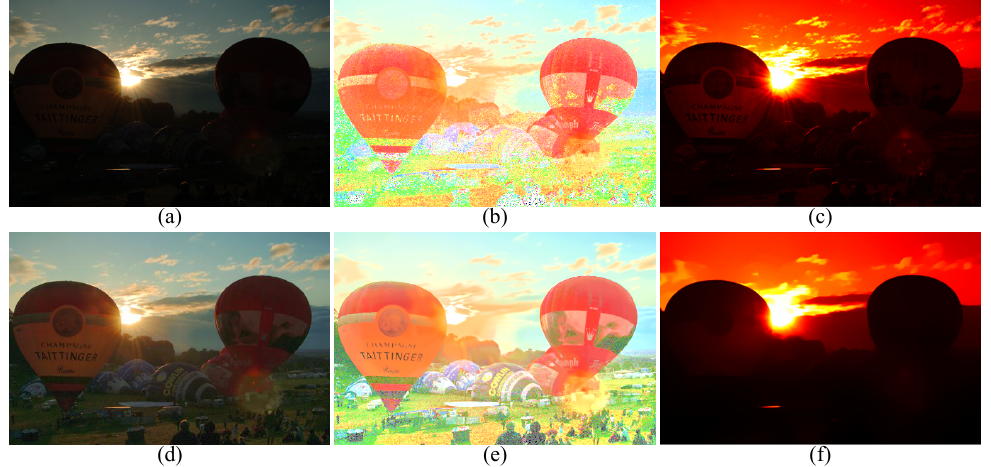
Figure 9. Visual evaluation of Retinex decomposition. ( a ) Original low-light image, ( b ) initial reflectance component ˆ R , ( c ) initial illumination component ˆ L , ( d ) corresponding enhancement result, ( e ) refined reflectance component R , ( f ) estimated illumination component L .